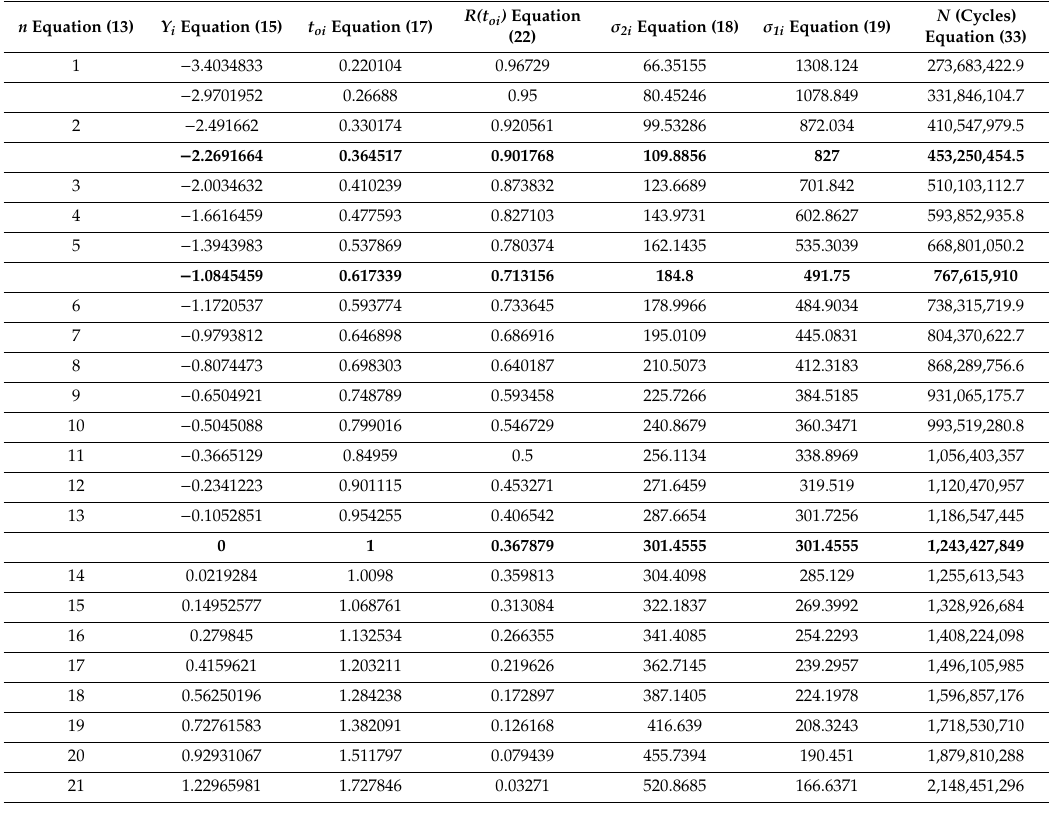
Table 5. Statistics of Weibull cycle to failure analysis.